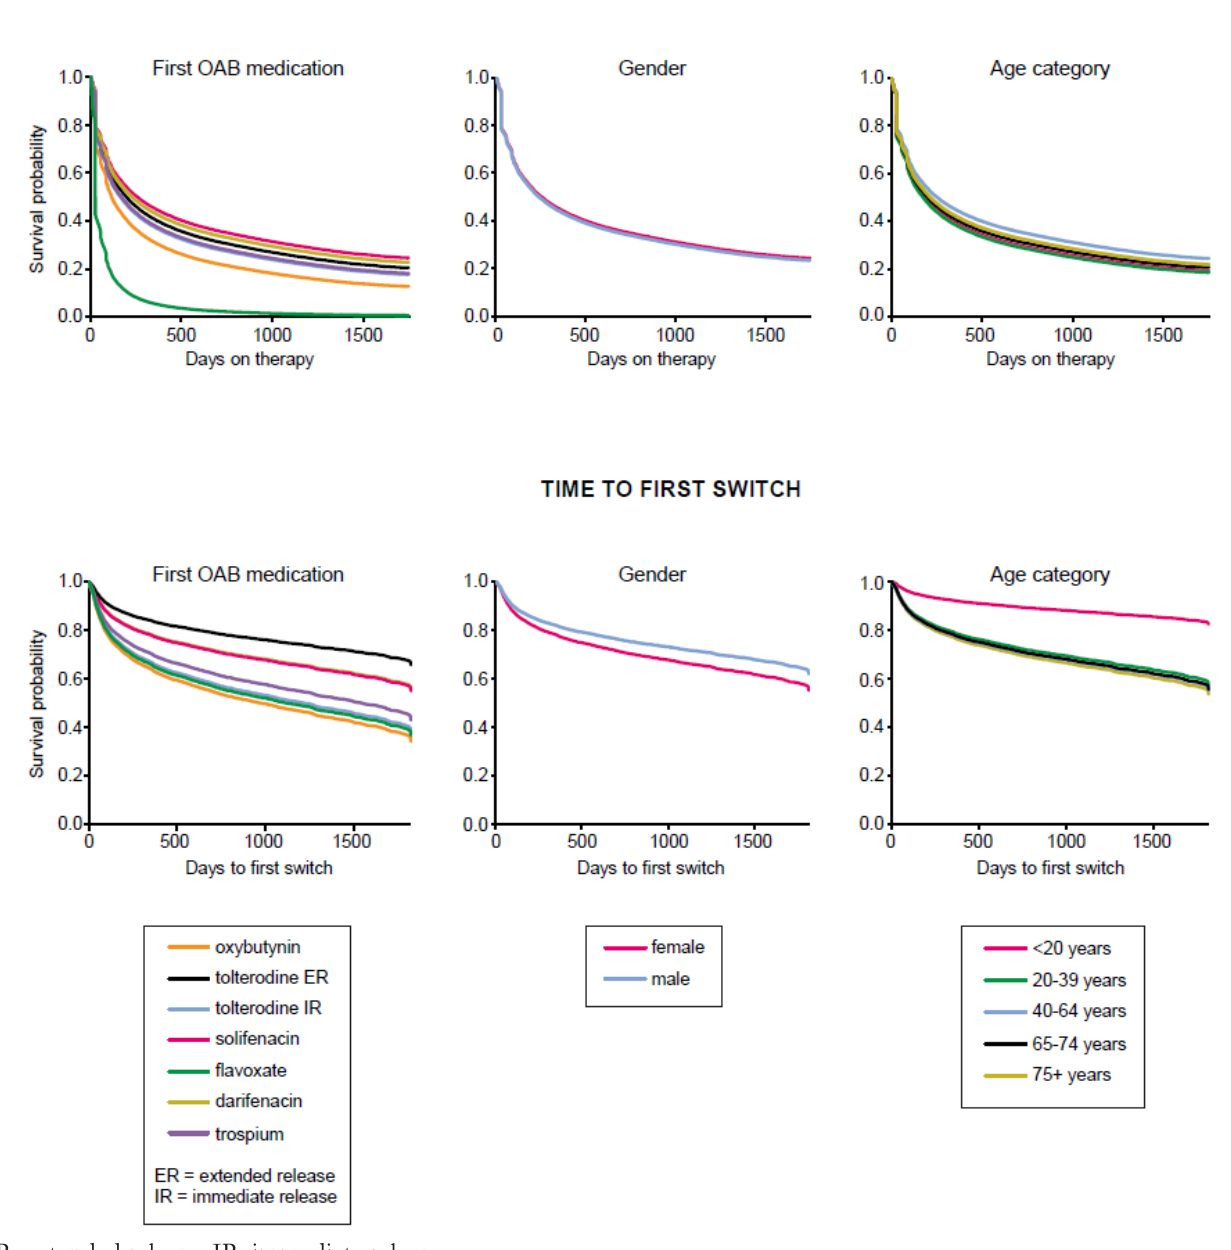
Figure 4. Time to Discontinuation and First Switch (Cox proportional hazards